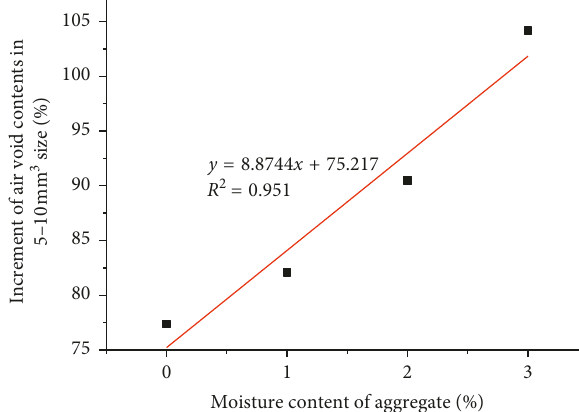
Figure 5: Moisture content in aggregates over an increment of air void contents in 5–10mm 3